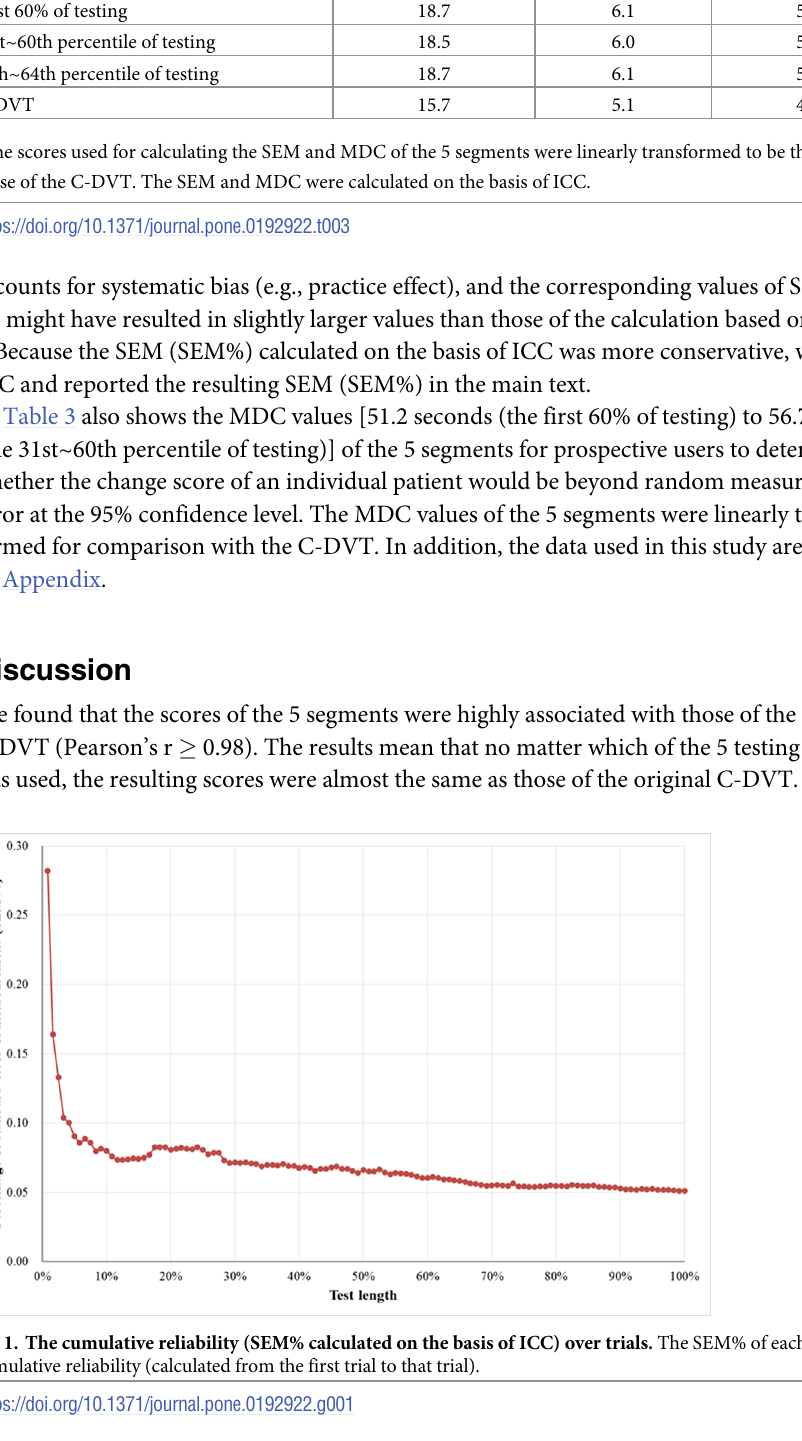
Table 3. Standard error of measurement (SEM) and minimal detectable change (MDC) of the 5 segments and the C-DVT (n = 44). Shortened method/ Measure